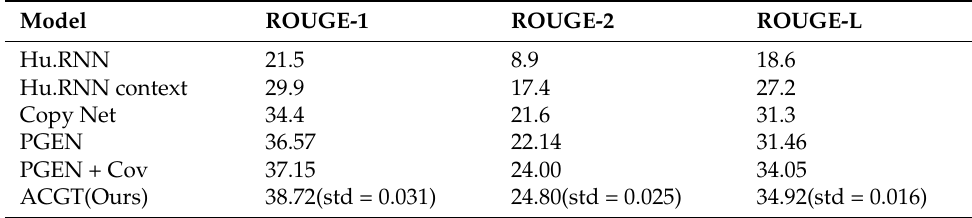
Table 5. ROUGE score of each model on LCSTS dataset